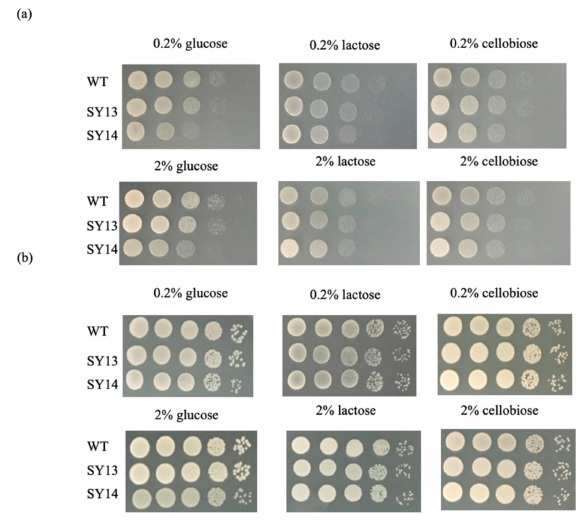
Figure 4. Growth of SY13 and SY14 on YAY agar plates containing glucose, lactose or cellobiose. Growth of SY13, SY14 and the parental strain (WT) on YAY agar plates supplemented with 0.2% glucose, 2% glucose, 0.2% lactose, 2% lactose, 0.2% cellobiose or 2% cellobiose were compared. The procedure for the spotting test is described in Materials and Methods. The plates after spotting were incubated at 40 ◦ C and photographs were taken at 12 h ( a ) and 24 h ( b